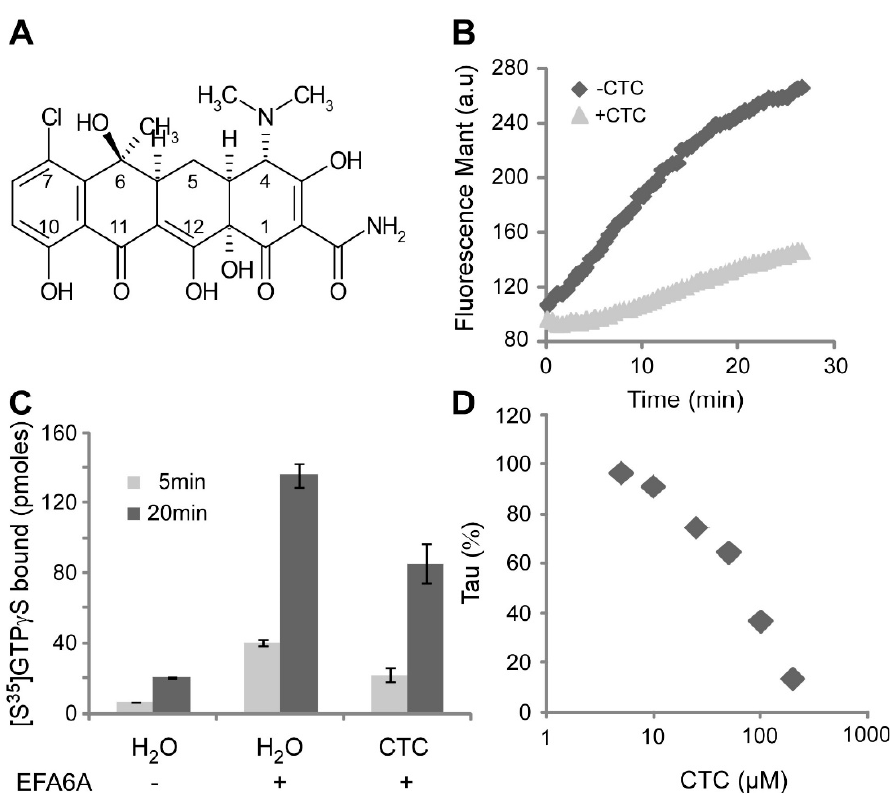
Figure 1. CTC blocks Arf6 GTP loading In Vitro. ( A ) Chemical structure of chlortetracycline (CTC). ( B ) mant-GTP loading on Arf6gly (2 µM) was carried out in presence of EFA6 (0.2 µM) and azolectin (0.4 g/L), with or without 100 µM CTC. Normalized fluorescence of a representative experiment is shown. ( C ) GTP γ S 35 loading on Arf6 was done with or without EFA6A and CTC for 5 and 20 min. ( D ) The mant-GTP loading experiment was done for different CTC concentrations and the slope of the resulting curves (tau in ∆ fluorescence per seconds) were measured and normalized without drug. IC50 was calculated at 75 µM.